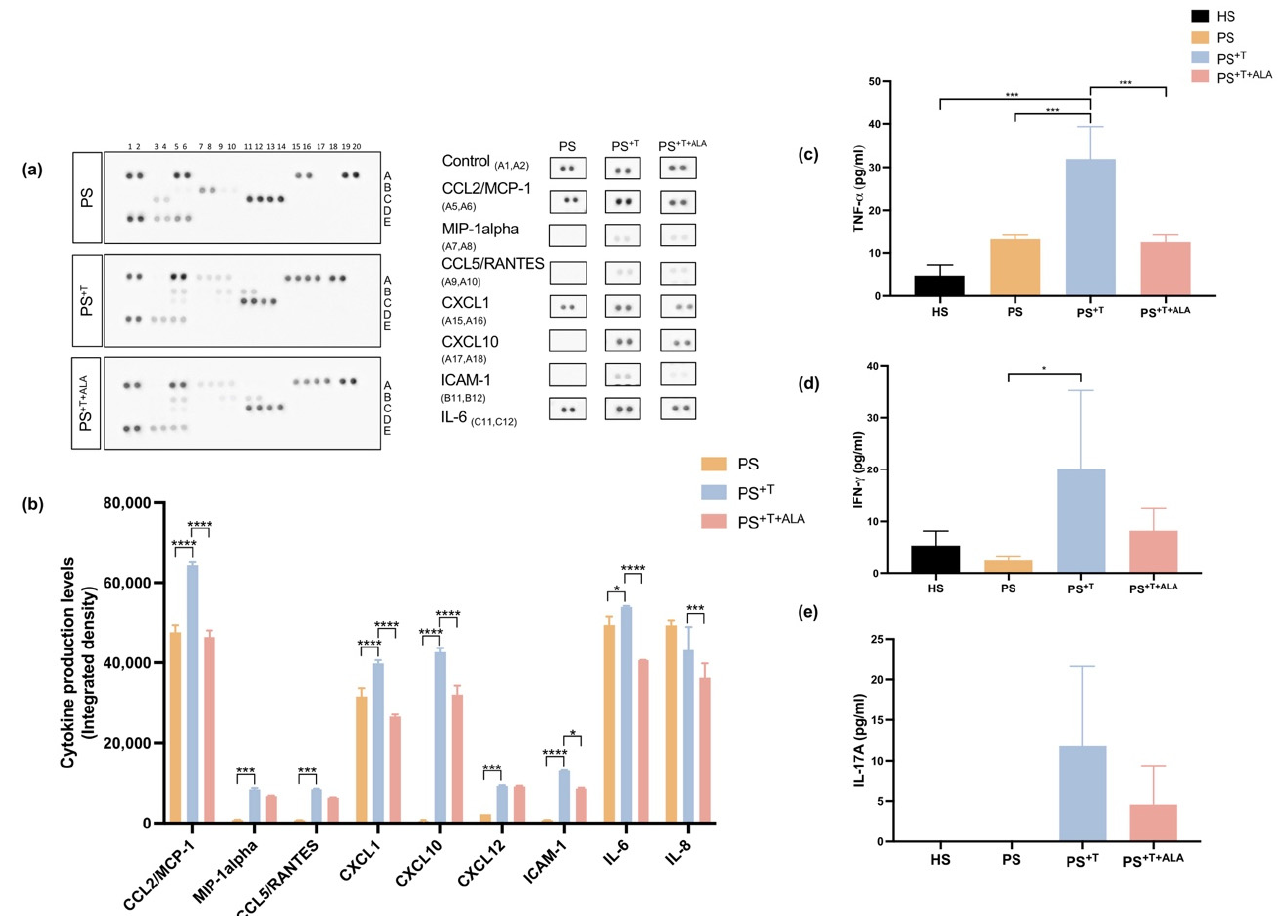
Figure 5. Levels of inflammatory cytokines in PS, PS +T and PS +T+ALA . ( a ) Culture supernatants from PS, PS +T and PS +T+ALA were used to detect secreted cytokines using the Human Cytokine Array kit from R&D Systems. The duplicate spots correspond to the cytokines whose synthesis was the most altered following ALA supplementation; ( b ) Densitometric analysis of the dot blot duplicates from panel ( a ); ( c ) Tumor necrosis factor- α (TNF- α ) levels in the culture medium of skin substitutes (N = 3 donors per condition, n = 2 culture supernatants per donor); ( d ) Interferon-gamma (IFN- γ ) levels in the